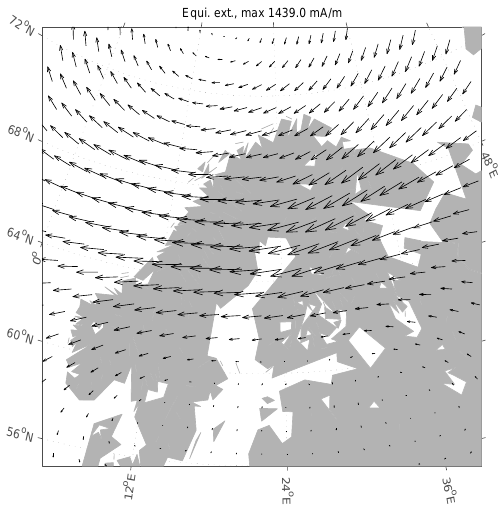
Fig. 7. Ionospheric equivalent currents ( J ext ) determined from the external part of the modeled magnetic field. Magnetic field data from the continental IMAGE array locations for time 01:55 UT are used (see Fig. 6). The maximum current amplitude is indicated in the title of the figure.